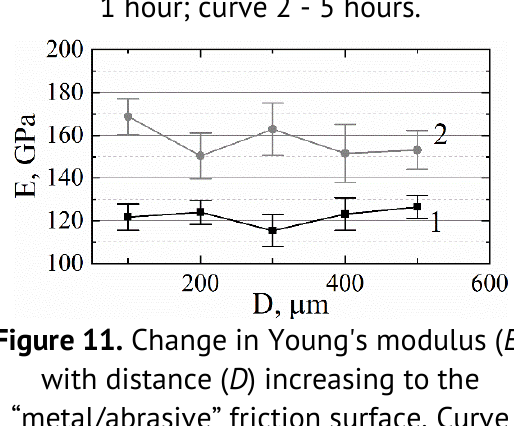
Figure 9. Dependence of hardness ( H ) on the distance ( D ) to the “metal/abrasive” friction surface. Curve 1 - friction for 1 hour; curve 2 - 5 hours.